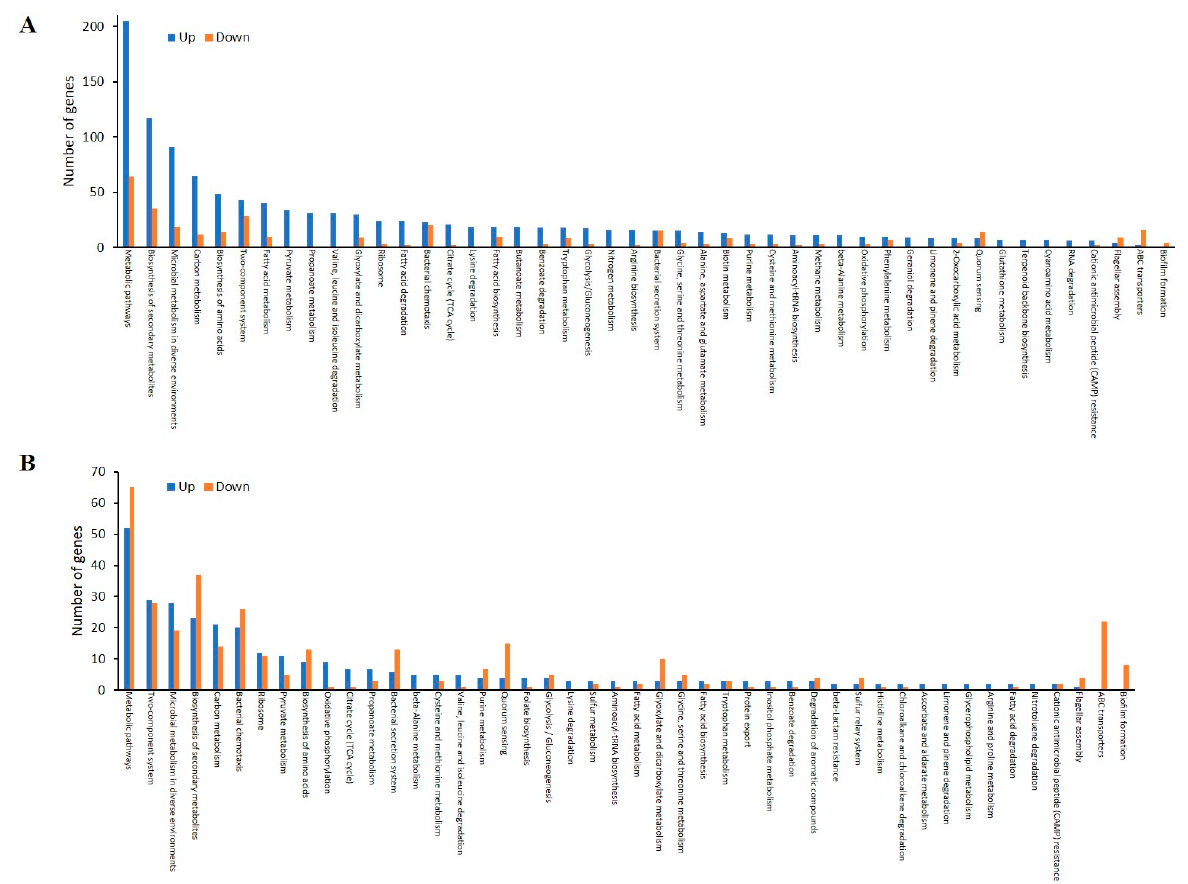
Figure 4. Comparison of KEGG pathways of over-expressed proteins from the planktonic ( A ) and biofilm ( B ) cells grown in control and antibiotic-impregnated catheters.